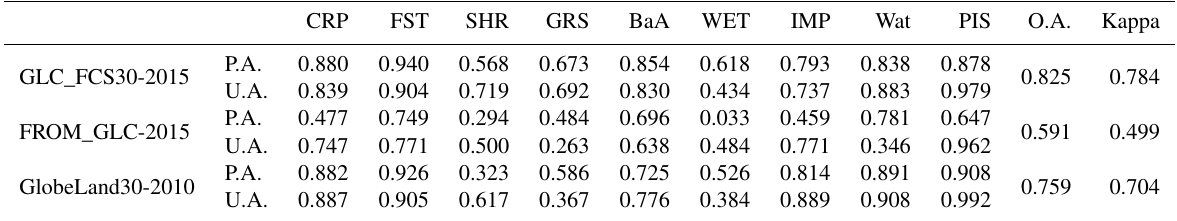
Figure 7. The confusion proportions for each of the land-cover types in LCCS level-2 validation scheme. Table 6. The accuracy metrics of three global 30m land-cover products using the validation